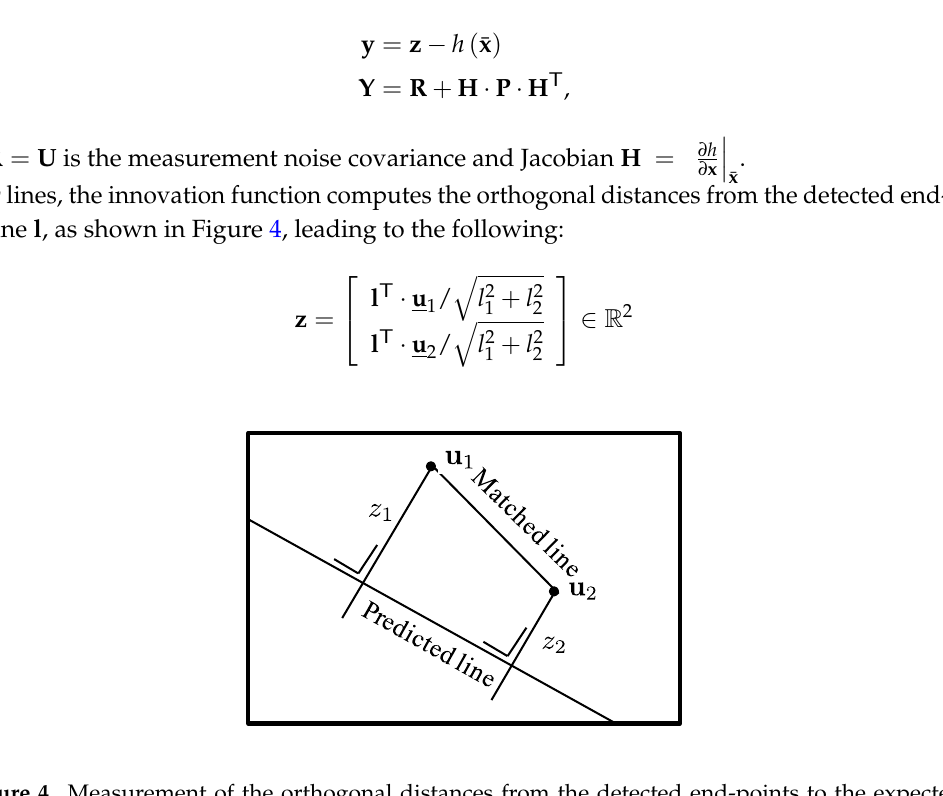
Figure 4. Measurement of the orthogonal distances from the detected end-points to the expected (or predicted) line.